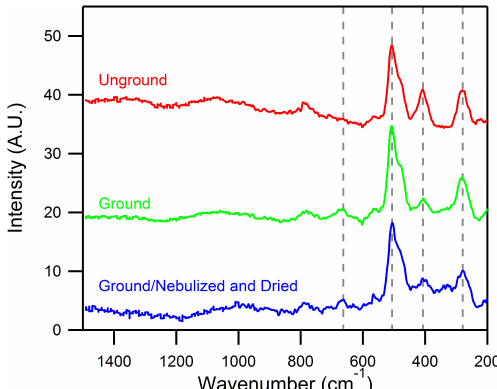
Figure 1. A set of example Raman spectra of unground, ground, and ground/nebulized Soufrière Hills volcanic ash. As shown, the main peaks at 507, 408, and 281cm − 1 (vertical dashed lines) are minimally affected by mechanical grinding and wet generation, sug- gesting that bulk chemical alteration does not occur. A small peak at 663cm − 1 , however, does appear in the ground samples, possi- bly due to better homogeneity of minor components compared to unground samples.